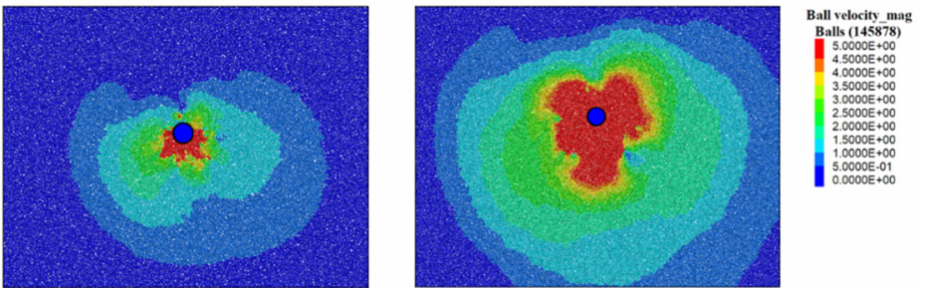
Figure 3. Blasting effects of concentrated blasting points.